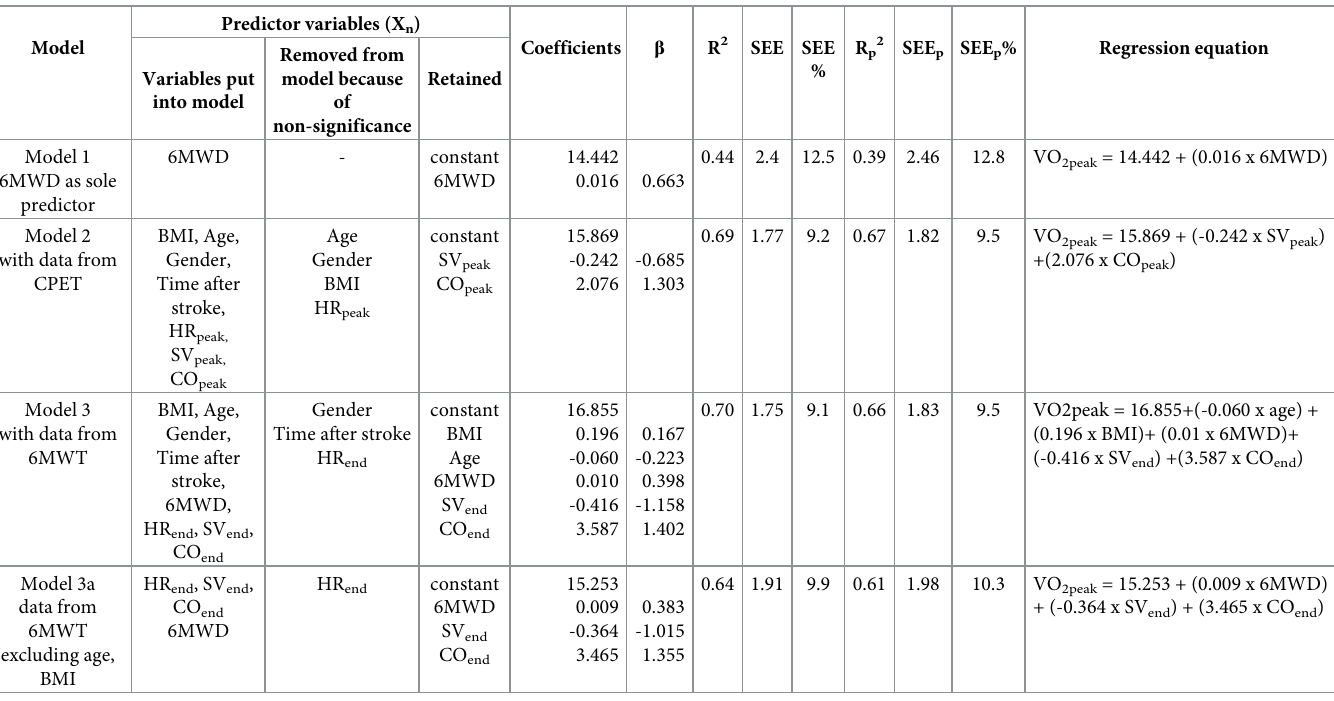
Table 4. Multiple regression analyses for prediction of VO 2peak .